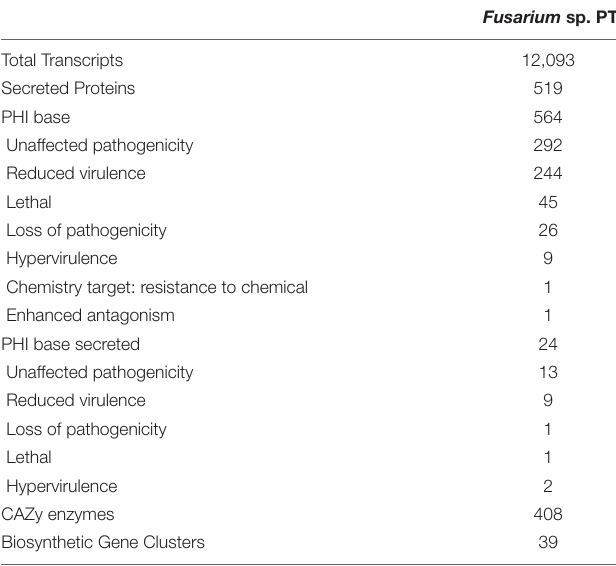
TABLE 3 | Characterization of the transcripts involved in